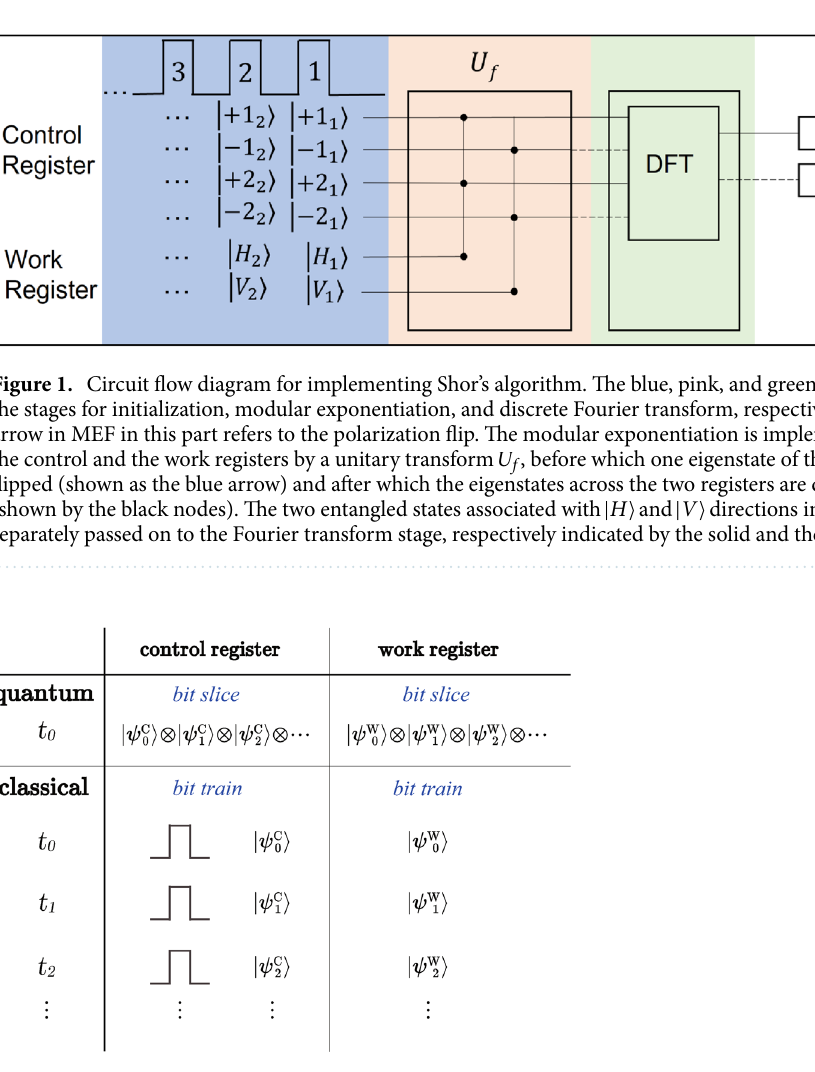
Figure 2. Illustration for the distinct data encoding schemes used by two entangled registers in typical quantum entangling implementations and our classical entangling implementation. In the former, the qubits of the control register are collectively entangled with the qubits of the work register; the bit-slice data in the two registers are entangled as cluster entangled states. In the latter, since the pulses are time ordered without inter- pulse interactions, the entangling encoding extends in time and is done one bit in the control register with one bit in the work register at a time. The time ordering is equivalent to spatial ordering in a light space and does not contribute to extra time complexity of the